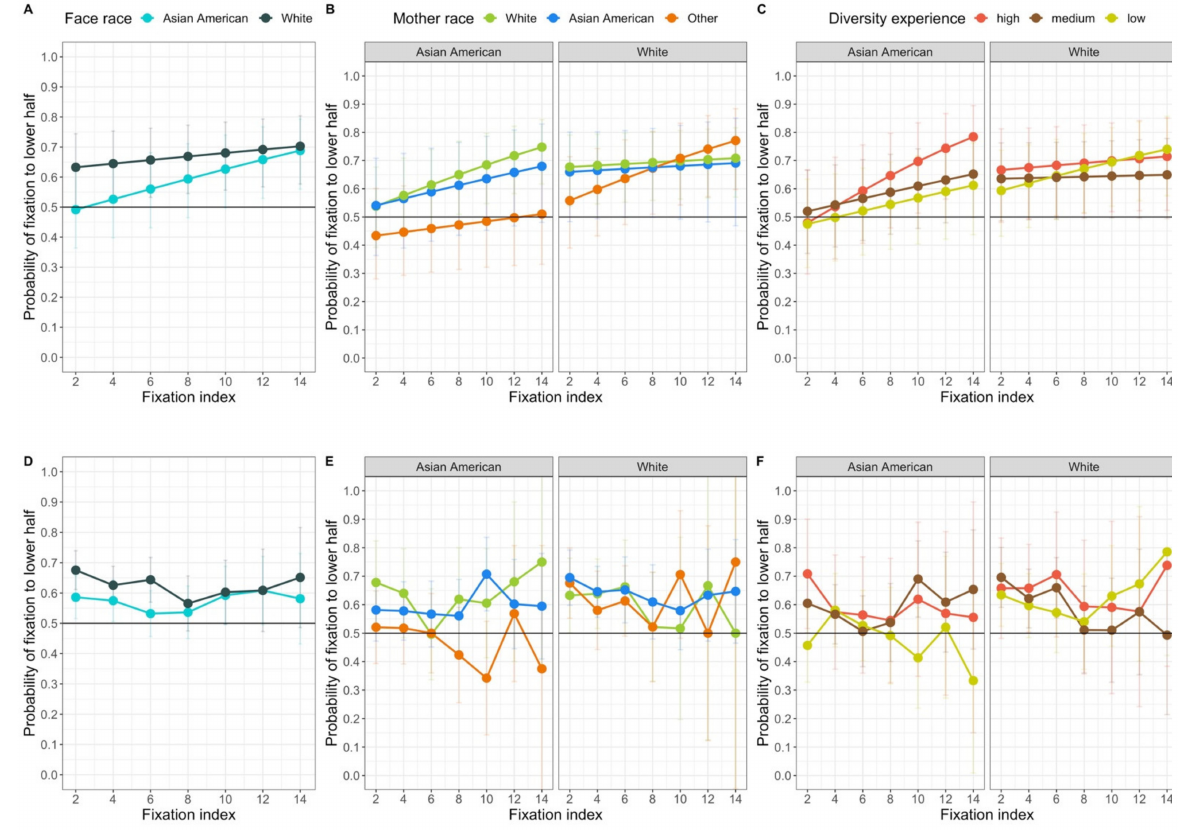
Figure 11. The probability of a fixation to the lower half of the face. Top: Model estimate for the probabilities on each index as a function of ( A ) face race, ( B ) face race and mother’s race, and ( C ) face race and diversity of experience. Bottom: Observed proportions on each index as a function of ( D ) face race, ( E ) face race and mother’s race, and ( F ) face race and diversity of experience. Error bars represent asymptotic upper and lower confidence limits. Although fixations are only plotted to fixation index 14, all fixations were entered in the